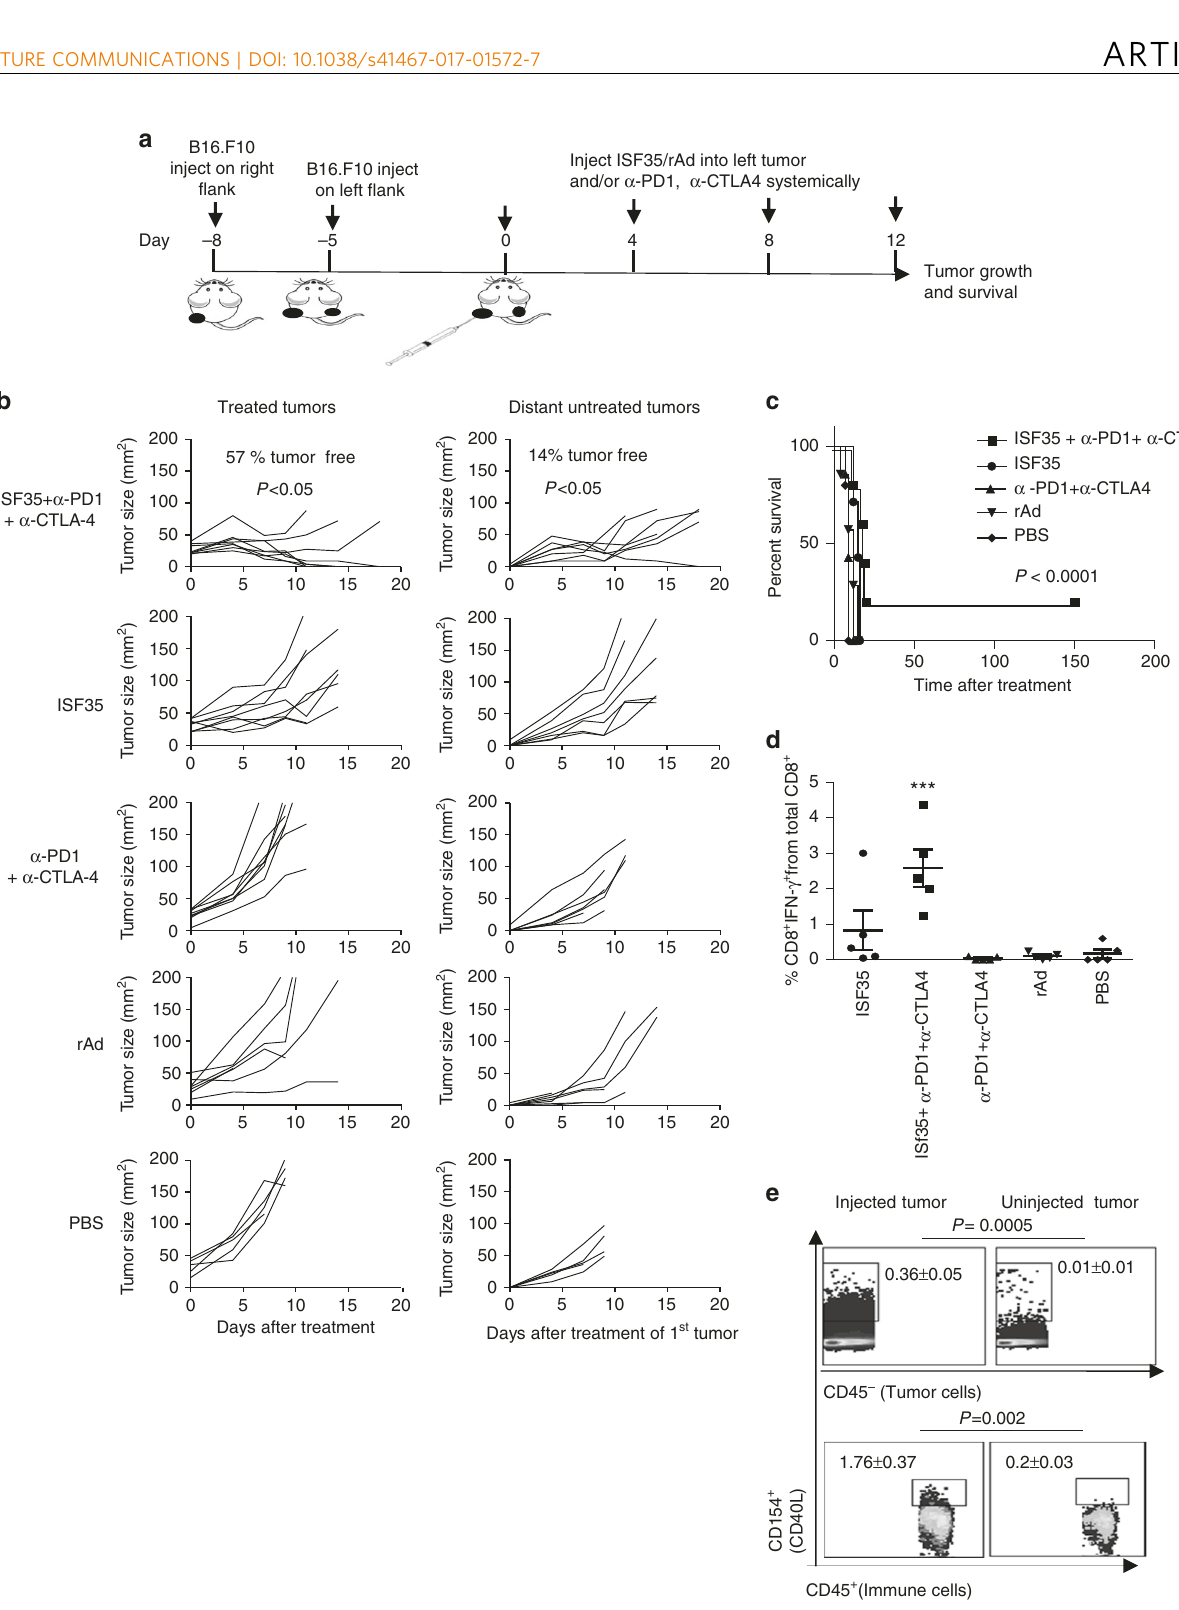
Fig. 6 Abscopal effect after intratumoral ISF35 with anti-CTLA-4 and anti-PD-1 antibody blockade. a Treatment strategy. b Growth of injected and distant, uninjected B16.F10 tumors ( n = 5 – 7). c Mouse survival ( n = 5 – 7). d Tumor antigen (p15E)-speci fi c IFN- γ producing CD8 T cells in circulation ( n = 5).